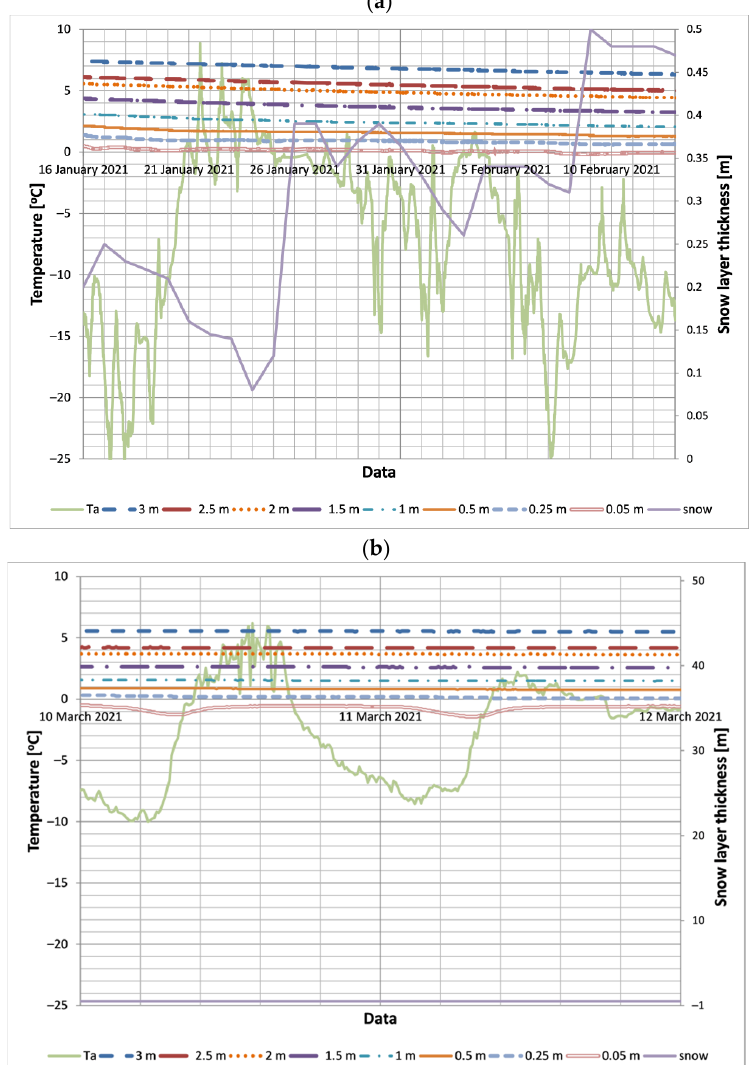
Figure 10. Temperature changes in the ground of point No. 2 in the snowy ( a ) and snowless ( b ) winter period.